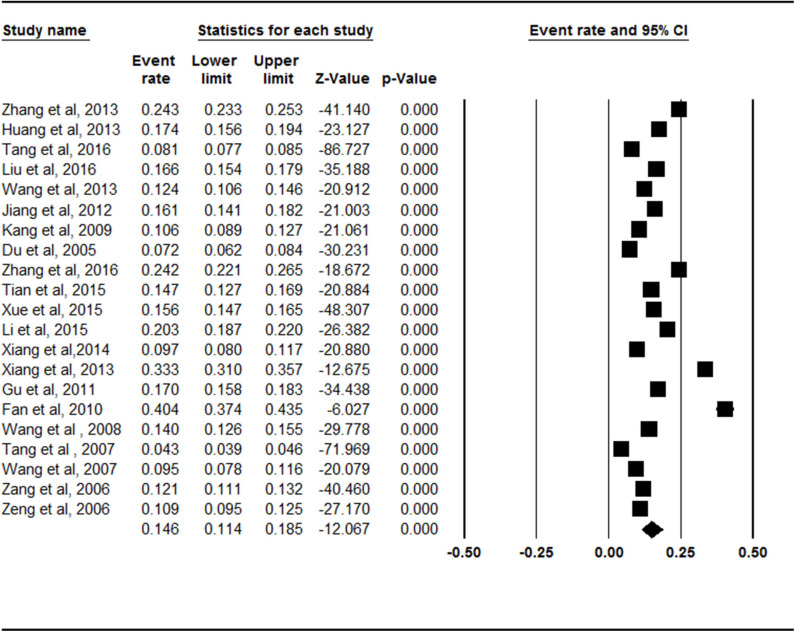
Forest plot of the overall prevalence rates of symptomatic knee osteoarthritis. CI, confidence interval. A total of 21 studies were included in this meta-analysis. The overall pooled prevalence of symptomatic knee osteoarthritis was calculated as 14.6% (95% CI = 0.114–0.185) through analyzing in a random-effects model.